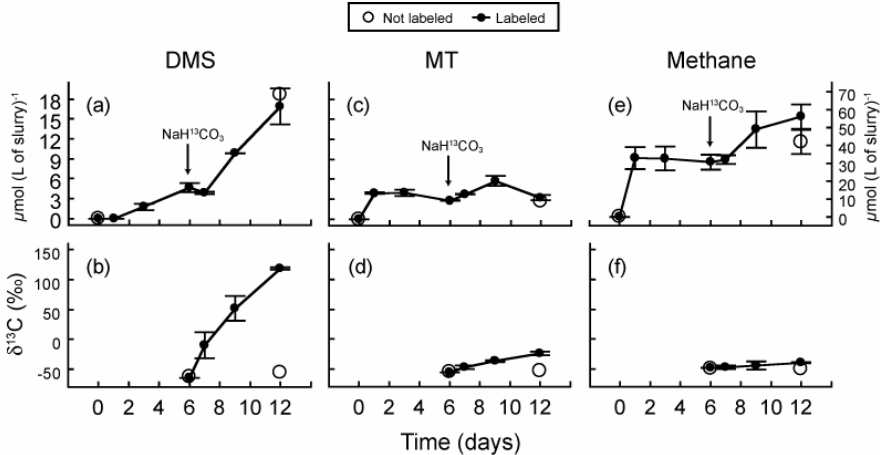
Fig. 3. 2 Fig. 3. Concentrations and stable carbon isotopic values of dimethyl sulfide (DMS), methanethiol (MT) and methane in sediment slurries under non-labeling and labeling conditions. NaH 13 CO 3 was added on day 6 of the incubation. Error bars represent ± 1 standard error of duplicate